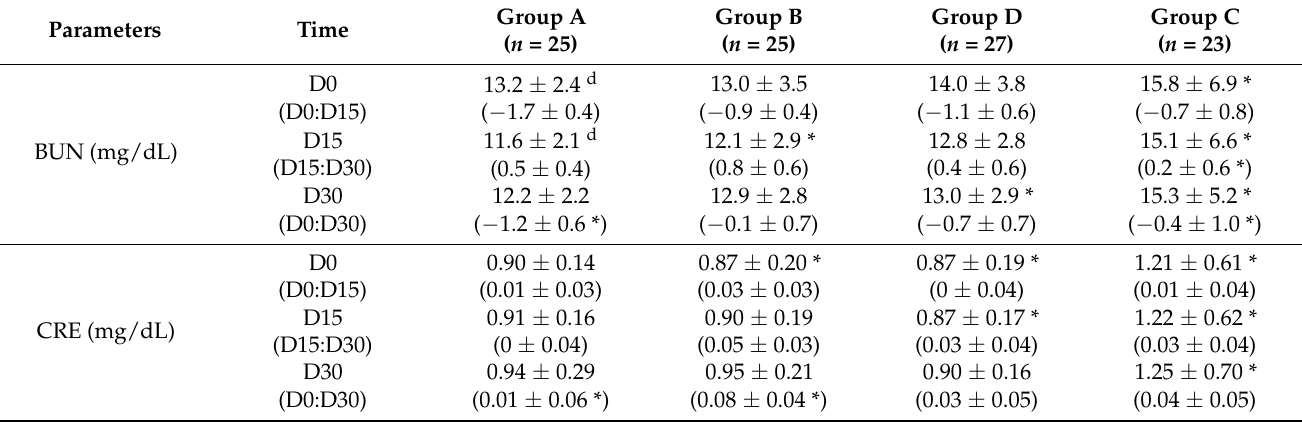
Table 4. Levels of blood urea nitrogen, serum creatinine, uric acid and electrolytes of non-anemic subjects who